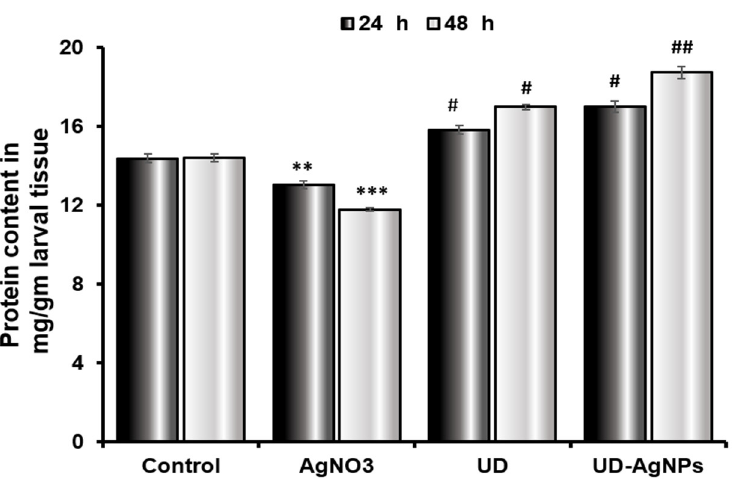
Figure 9. The protein concentration in third-instar Drosophila melanogaster (Oregon R+) larvae treated with AgNO 3 , UD, and UD-AgNPs for 24 h and 48 h. The results are the mean ± SD of three replicates of the same experiments. Significance is ascribed as ** p < 0.01, and *** p < 0.001 vs. control. # = significance at p < 0.05, and ## p < 0.01 compared with AgNO 3 . AgNO 3 = silver nitrate, UD = Urtica dioica , and UD-AgNPs = biosynthesized silver nanoparticles of Urtica dioica.